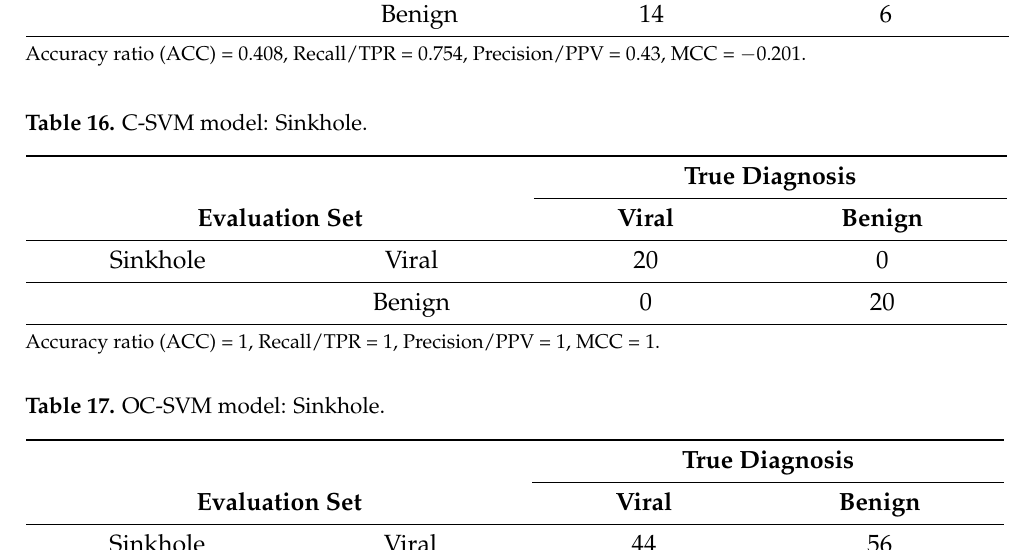
Table 15. OC-SVM model: SF&BH-BN. True Diagnosis Evaluation Set Viral Benign SFBH-BN Viral 43 57 Benign 14 6